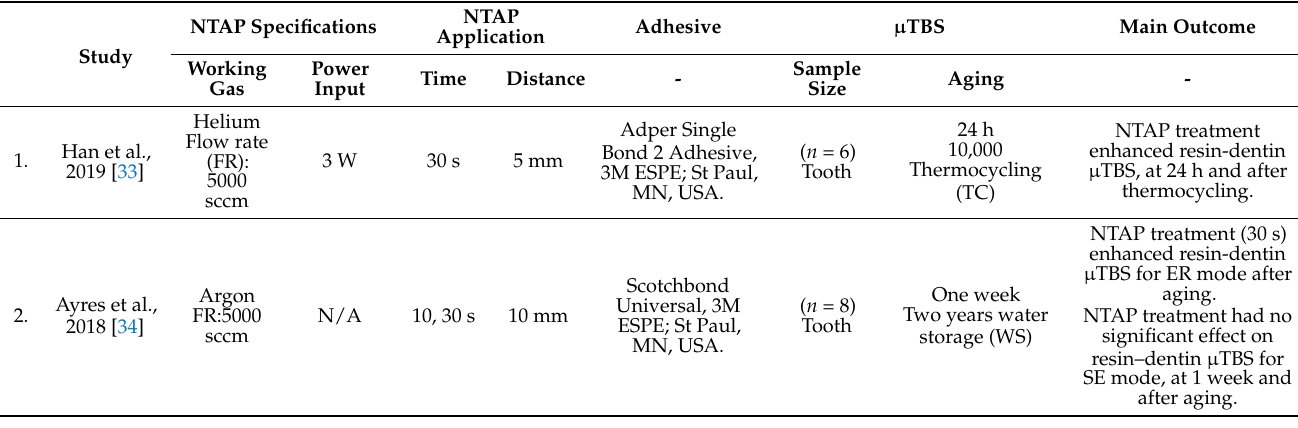
Table 1. Data extraction items from the studies included in the